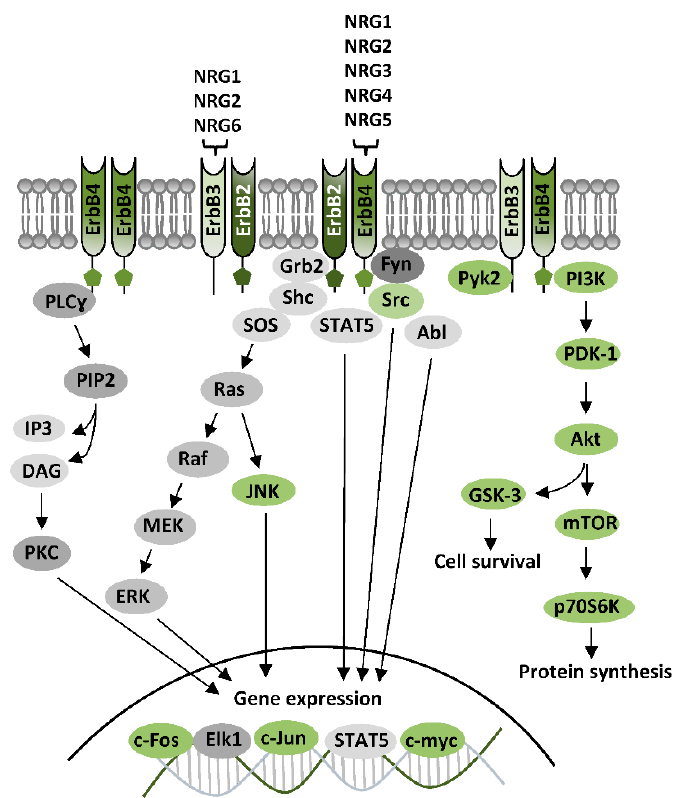
Figure 3. ErbB receptors and their signaling pathways. Diagram showing functional ErbB dimers, neuregulins (NRGs) binding and canonical ErbB signaling pathways. NRGs-induced ErbB stimulation activates PI3K-Akt-mTOR and GSK-3 pathways, which foster protein synthesis and cell survival, as well as Ras-Raf-MEK-ERK pathway or PLC-PKC pathway, mainly involved in gene expression regulation. Other ErbB e ff ectors are kinases like Src, Abl, Pyk2, Fyn, JNK, and the signal transducer and activator of transcription 5 (STAT5), which a ff ect gene expression by regulation of nuclear transcriptional